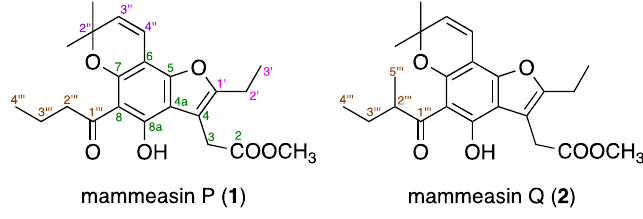
Figure 1. Structures of mammeasins P ( 1 ) and Q ( 2 ).